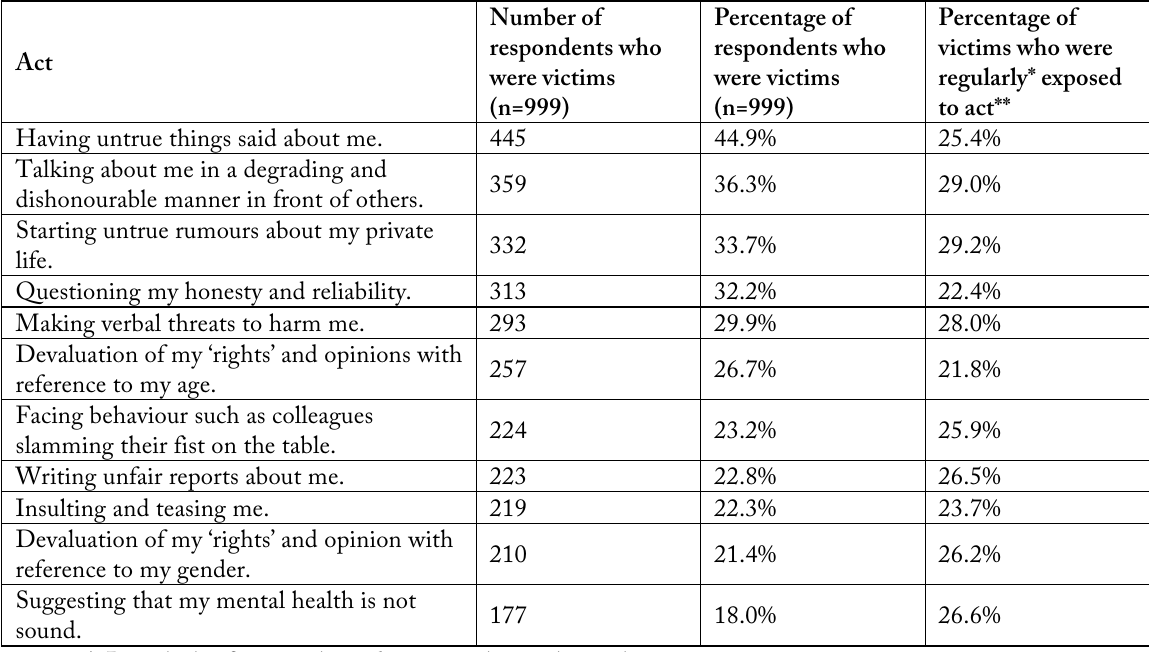
Table 5: Respondents who experienced behaviour undermining the victim as a person Act